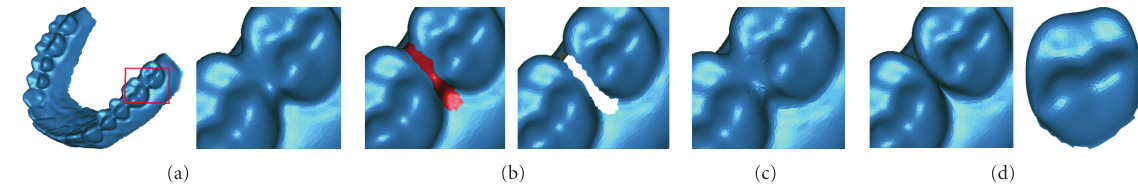
Figure 1: A general scheme of the single-tooth modeling.(a) Zoom view of the local region corresponding to the left first and second molars. (b) Fusion region identified and removed. (c) Restoration result with the hole filled directly (d) Restoration result that satisfies the biocharacteristics of the